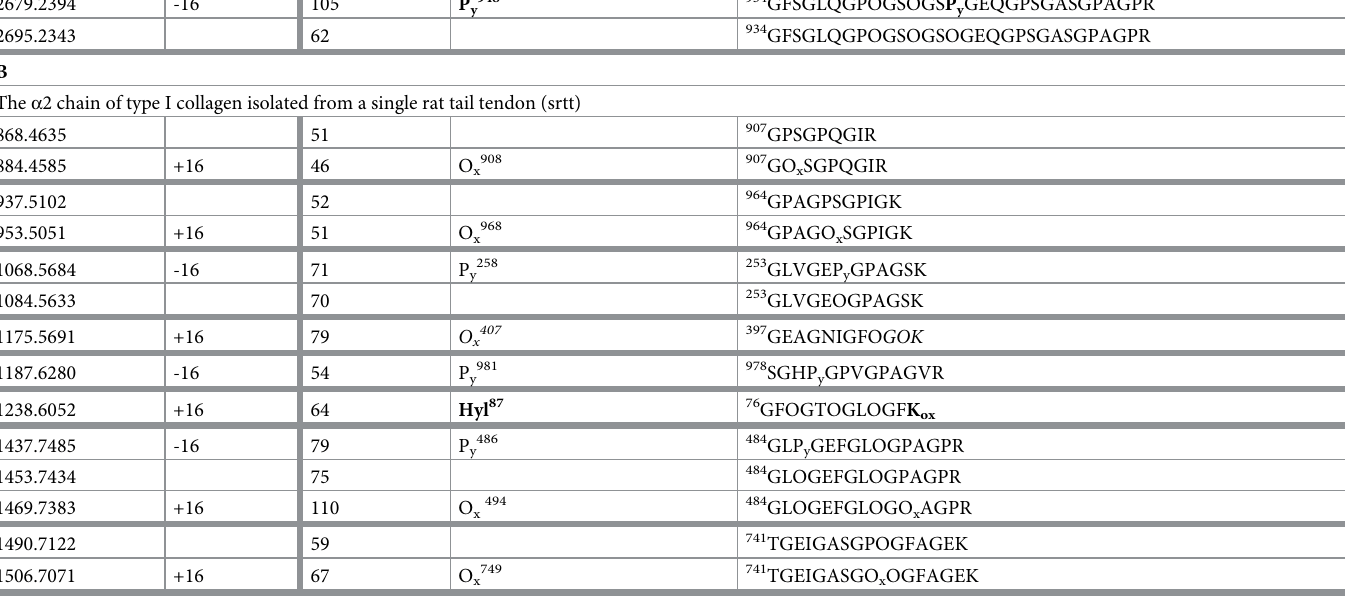
B The α 2 chain of type I collagen isolated from a single rat tail tendon